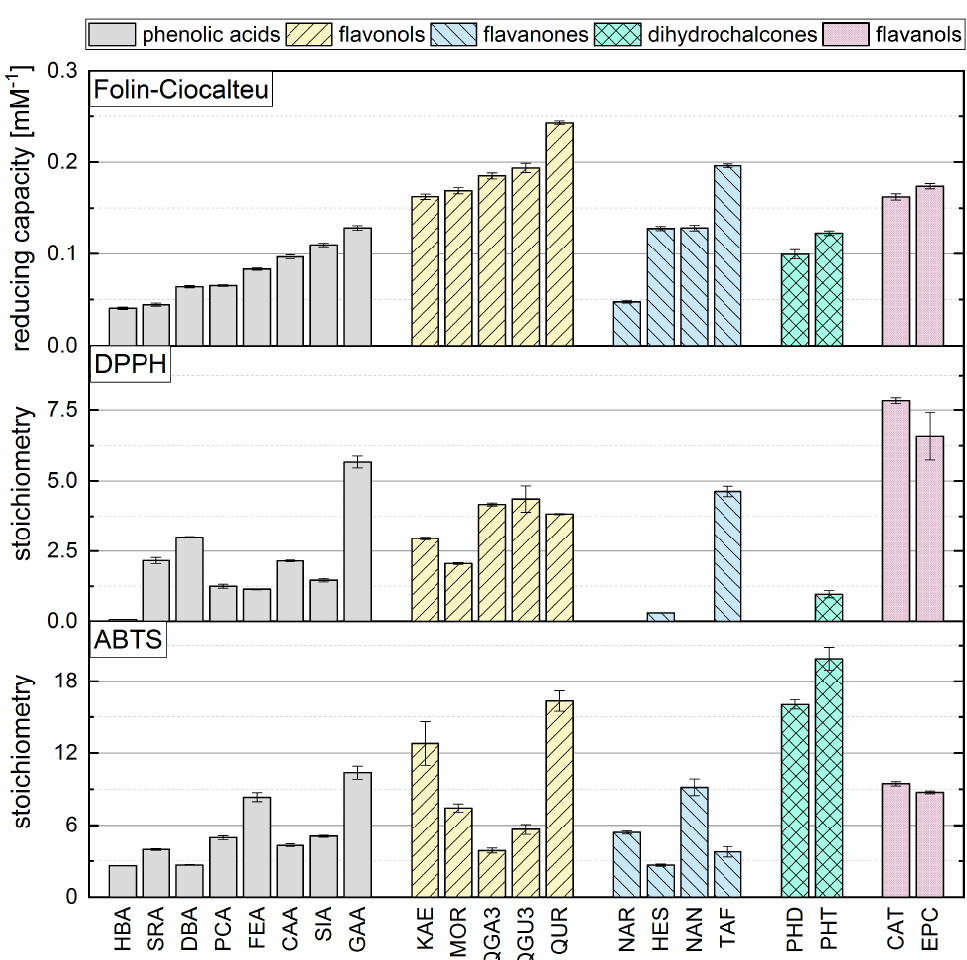
Figure 5. The reducing capacity of all standard references compounds measured in the FC assay in comparison to DPPH and ABTS assays, which are reproduced with permission from Platzer et al. (2021)